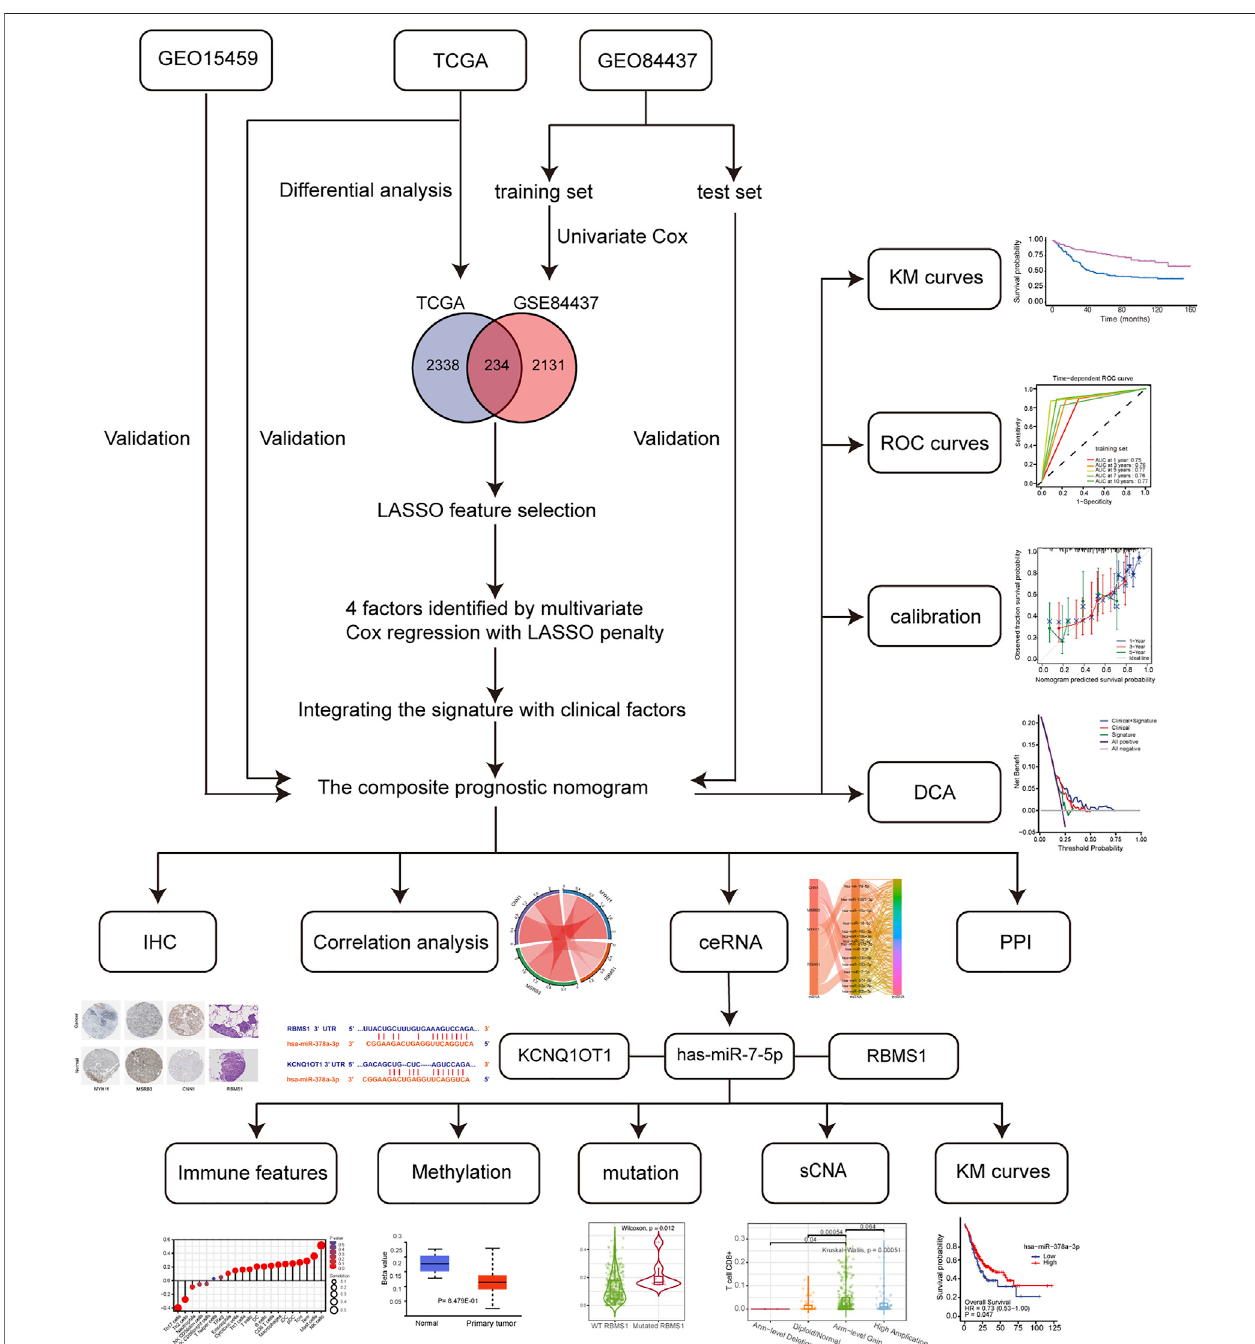
FIGURE 1 | Flowchart of the study design, including data collection and analysis.